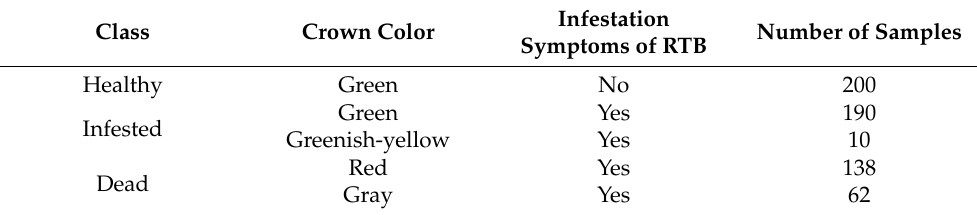
Figure 3. Number of RTB in infested trees with different-colored crowns. Table 1. The assessment indicators of pine health status and the number of